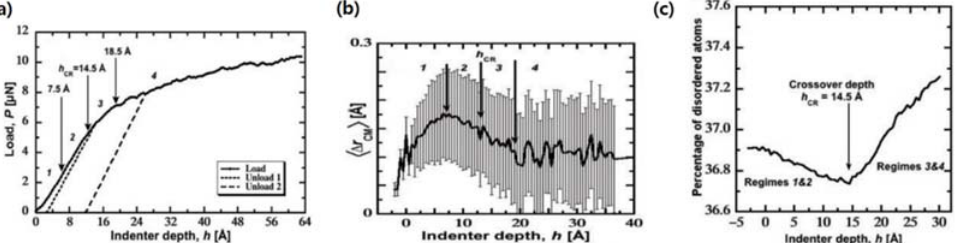
Figure 6. ( a ) Load–displacement curve of n-SiC. ( b ) Average displacement with standard deviation to the center of mass of grains with respect to indentation depth curve. ( c ) Percentage of the disordered atoms–displacement curve. Reproduced with permission [92]. Copyright 2022 Science.